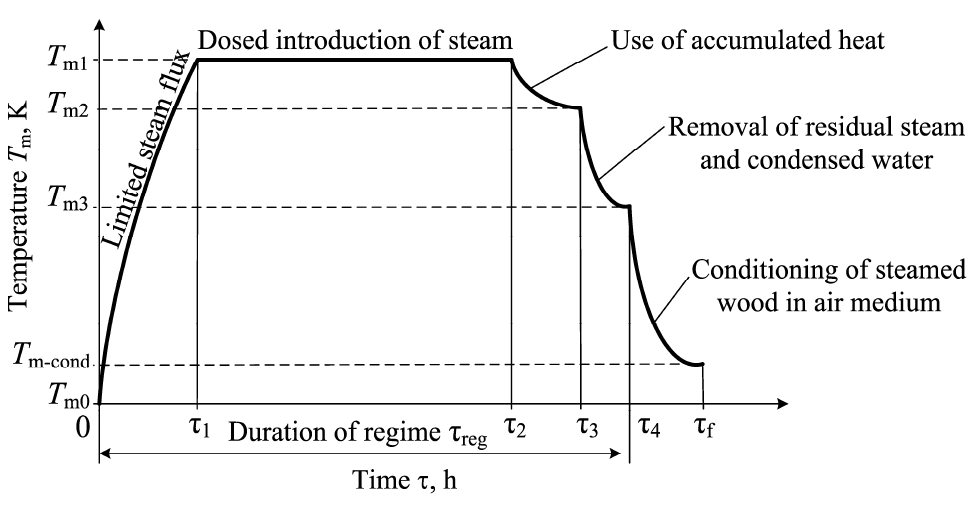
Figure 3. Typical change in T m during steaming of prisms in an autoclave and air conditioning.